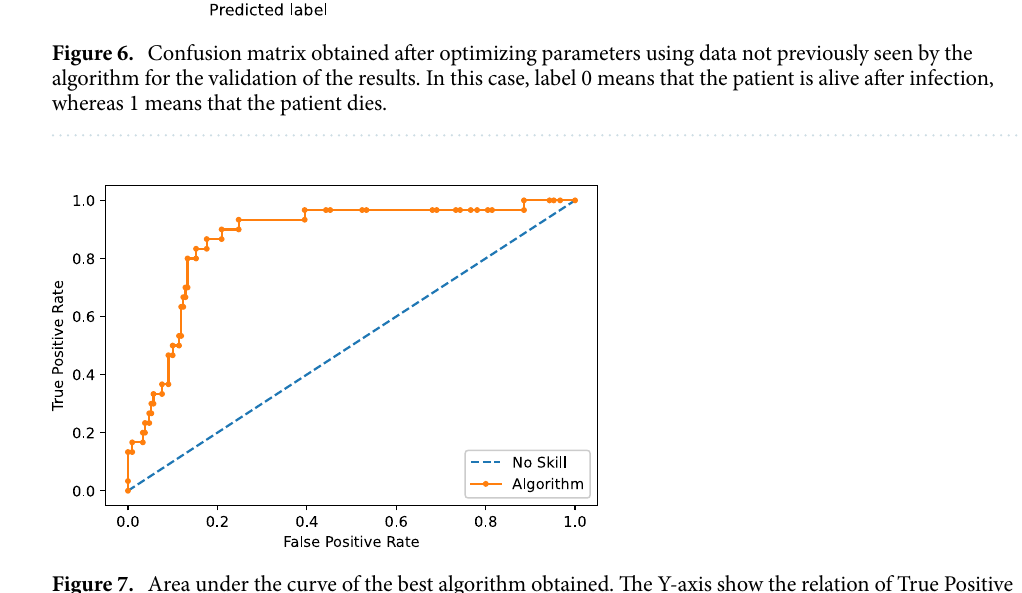
Figure 7. Area under the curve of the best algorithm obtained. The Y-axis show the relation of True Positive (TP) rate and the X-axis show False Positive (FP) rate with AUC =